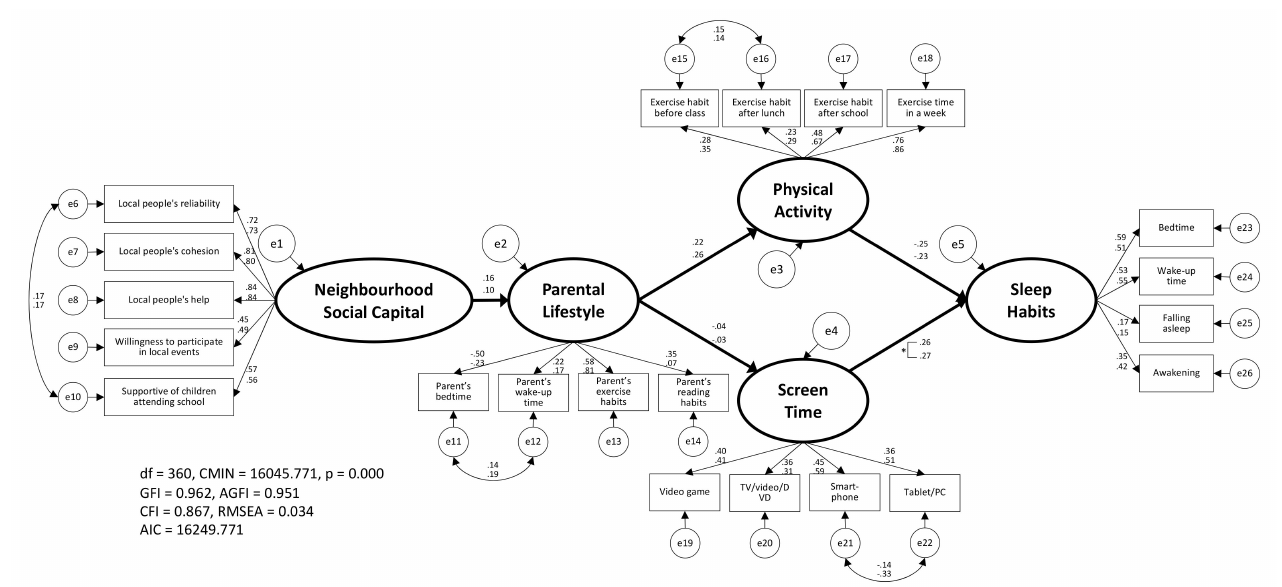
Figure 5. The pathways linking children’s sleep habits by school stage. This model was verified by structural equation modeling using the bootstrap method. The numbers in Figure 5 pertain to upper: elementary school and lower: junior high school, and all estimates, excluding the Parental Lifestyle → Screen Time values, are significant. * The difference between elementary school and junior high school is significant at p <